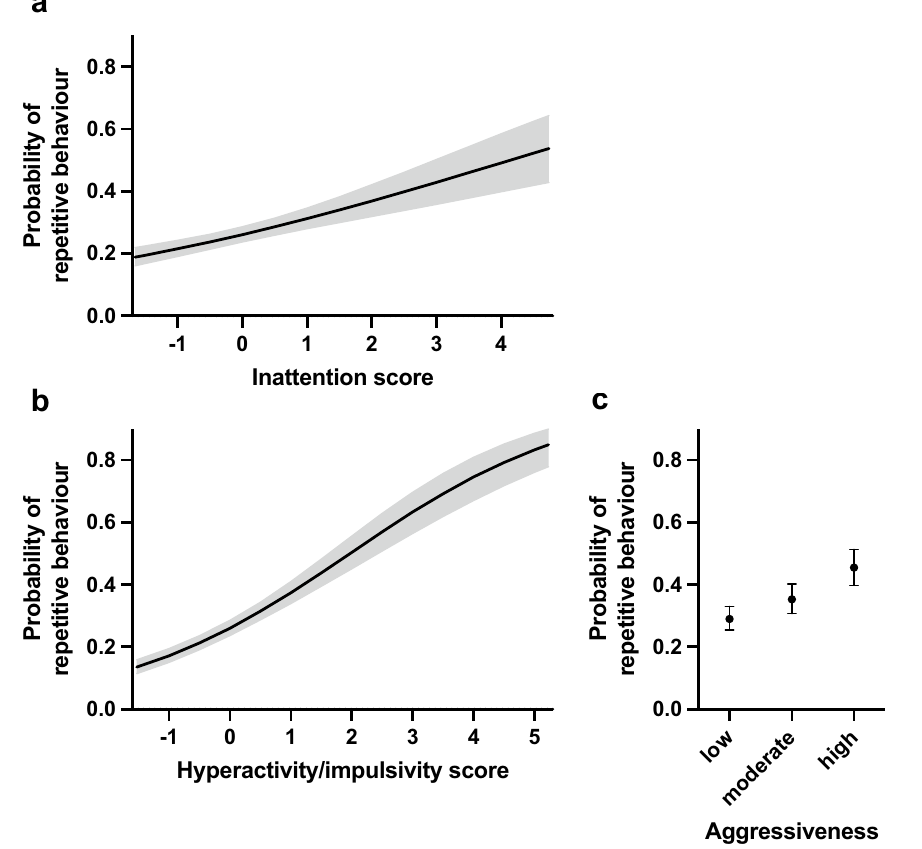
Figure 2. The effects of inattention score ( a ), hyperactivity/impulsivity score ( b ), and aggressiveness ( c ) on the probability of repetitive behaviour in the logistic regression analysis. Grey area ( a, b ) and error bars ( c ) indicate 95% confidence limits. N =